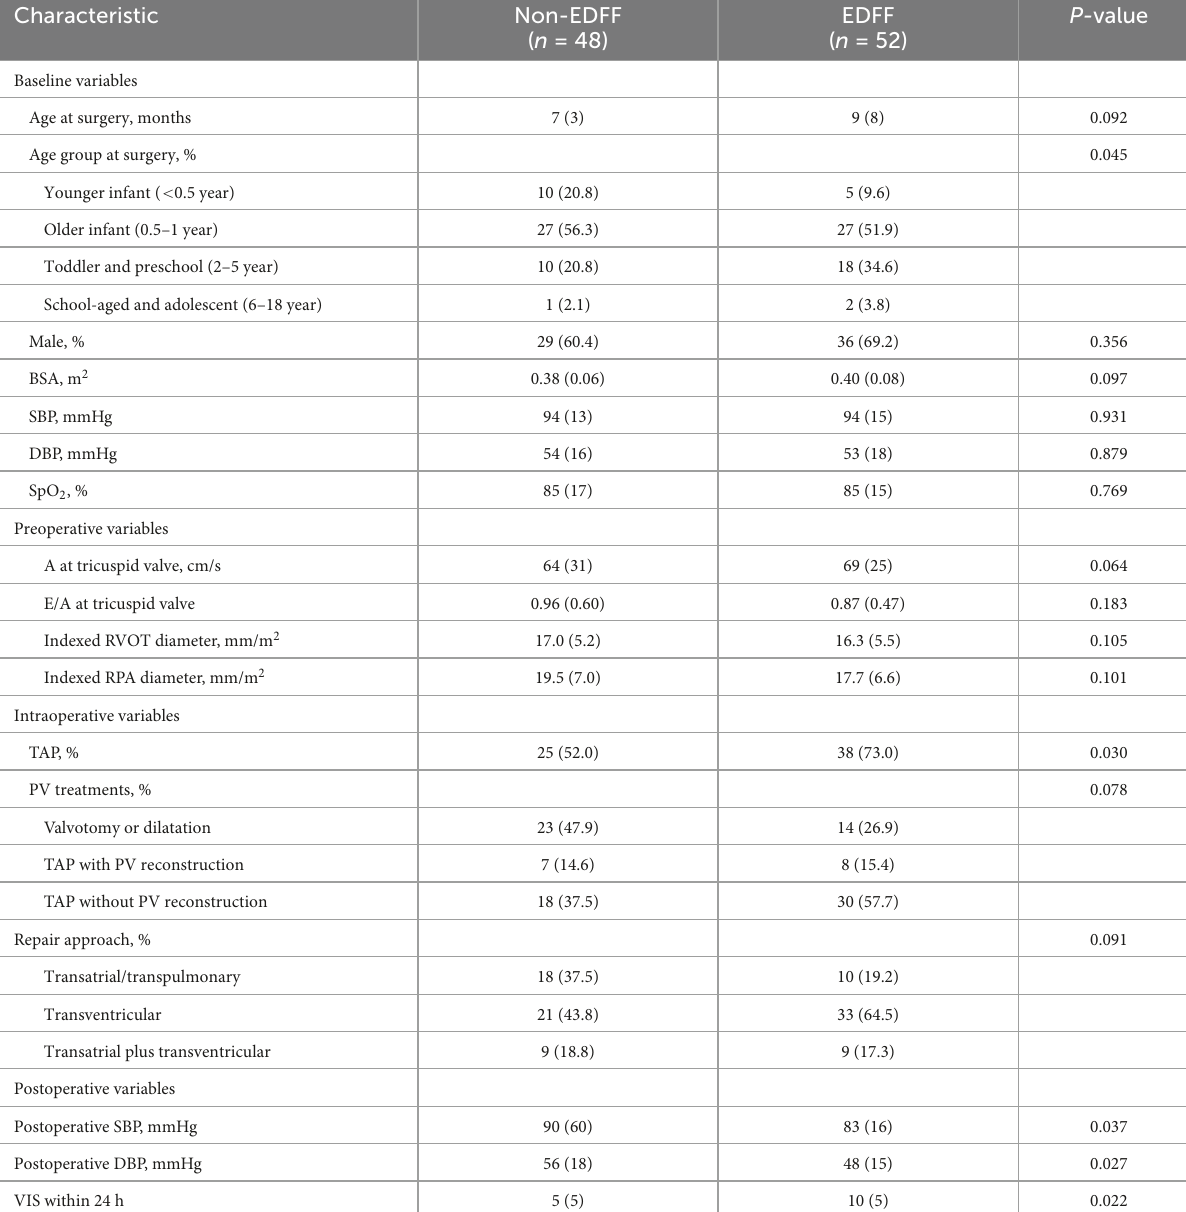
TABLE 1 Baseline and selected perioperative